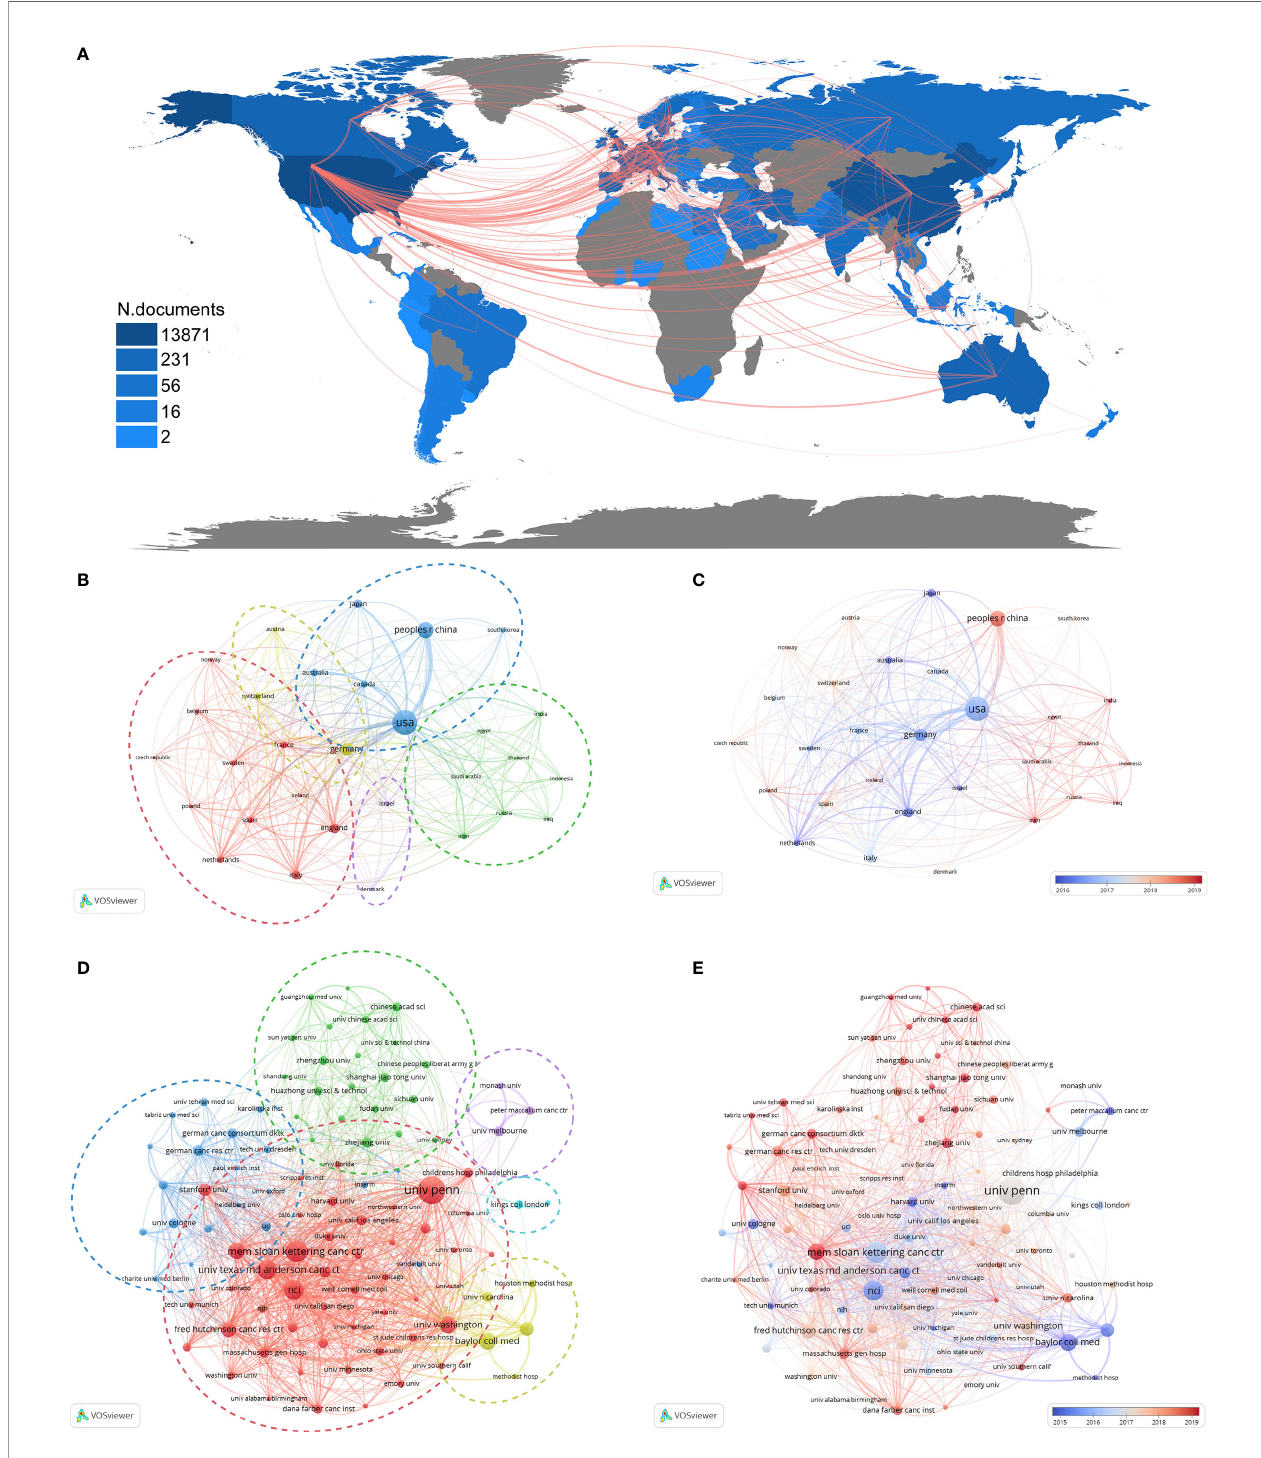
FIGURE 3 | Collaboration networks among countries and among institutions. (A) The collaboration map among countries. Color shades represent the number of publications in each country, and red lines indicate cooperation between two countries. Each node in (B – E) represents a country or an institution, and each line represents a link between two countries or institutions. The dotted circles in different colors in (B, D) indicate the corresponding clusters of countries and institutions. (B) The cooperation network among the top 30 most productive countries. (C) The time-overlay map of the cooperation network among the top 30 most productive countries. (D) The cooperation network among the top 100 most productive institutions. (E) The time-overlay map of the cooperation network among the top 100 most productive